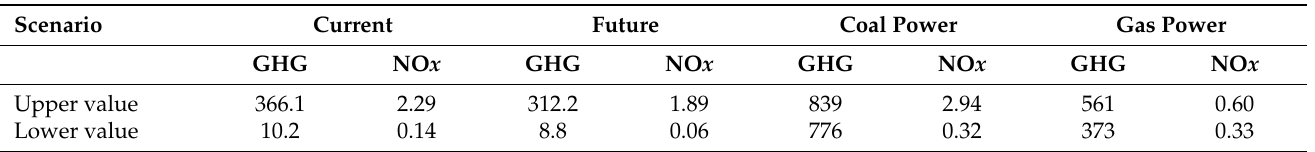
Table 7. Life cycle of GHG and NO x emissions of PHP+CCGT technology under current and future